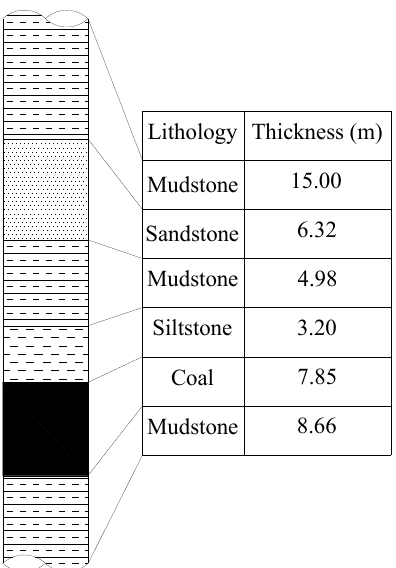
Figure 4. Geological column.